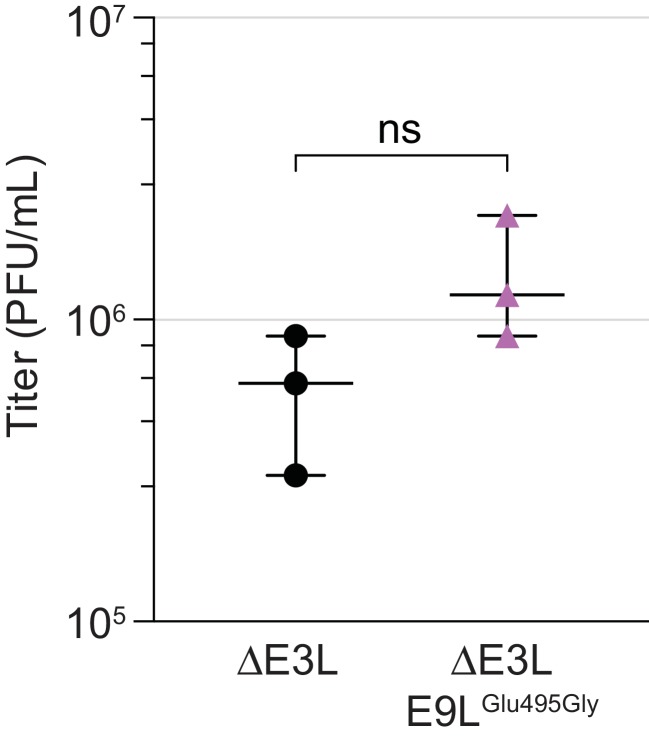
The E9LGlu495Gly variant does not contribute to virus replication.A virus clone containing the E9LGlu495Gly variant as the only genetic change relative to ΔE3L was isolated following four rounds of plaque purification in BHK cells (clone a in Figure 1C). Replication was measured in comparison to ΔE3L virus after 48 hr of infection (MOI 0.1) of HeLa cells in triplicate. Titers were measured multiple times in BHK cells by plaque assay, shown with median and 95% confidence intervals. ns, not significant by unpaired 2-tailed t test with Welch’s correction.10.7554/eLife.35453.012Figure 1—figure supplement 3—source data 4.Data used to generate Figure 1—figure supplement 3.10.7554/eLife.35453.013Figure 1—figure supplement 3—source data 5.Statistics for Figure 1—figure supplement 3, unpaired 2-tailed t test with Welch’s correction.